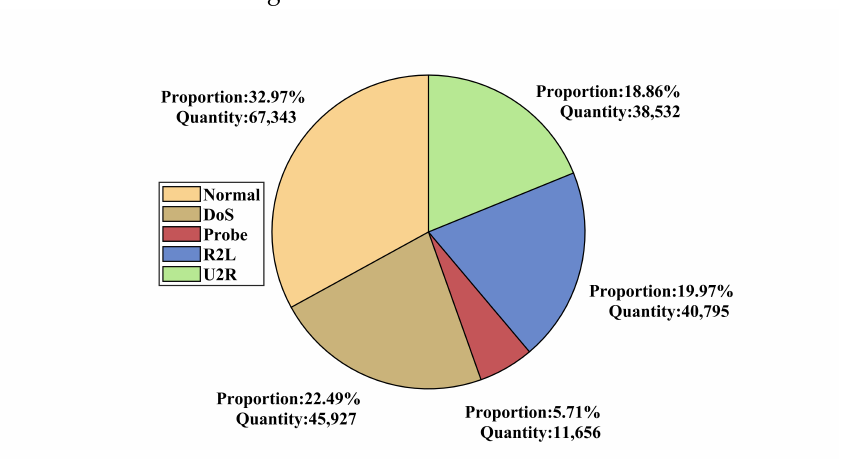
Figure 8. The percentage of different types of samples in the training